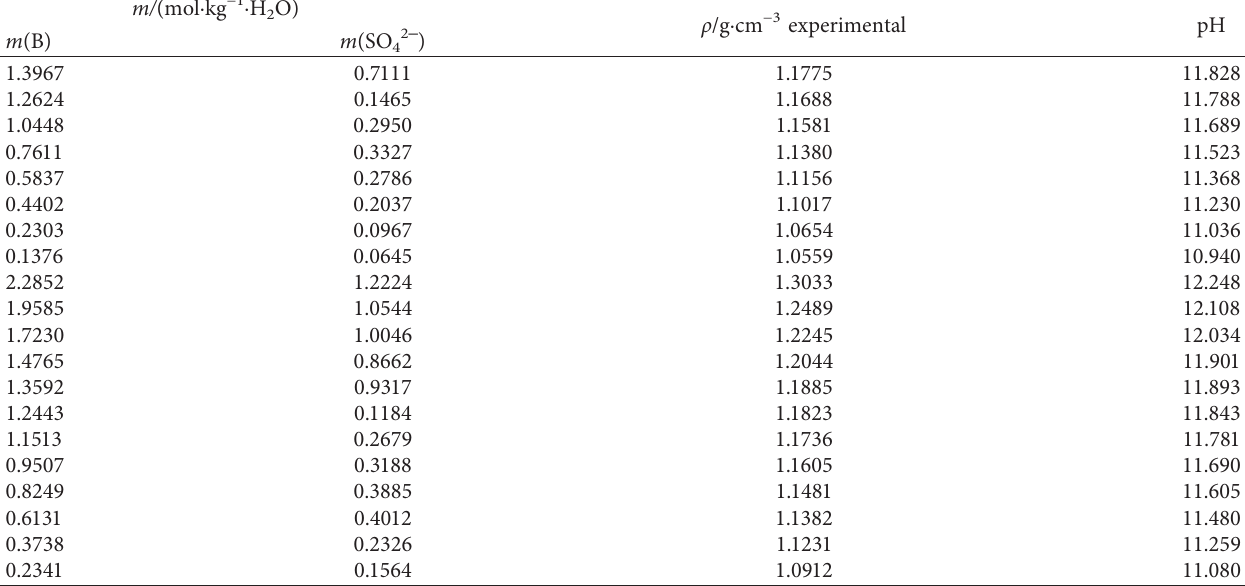
Table 3: Density and pH values in the system NaBO